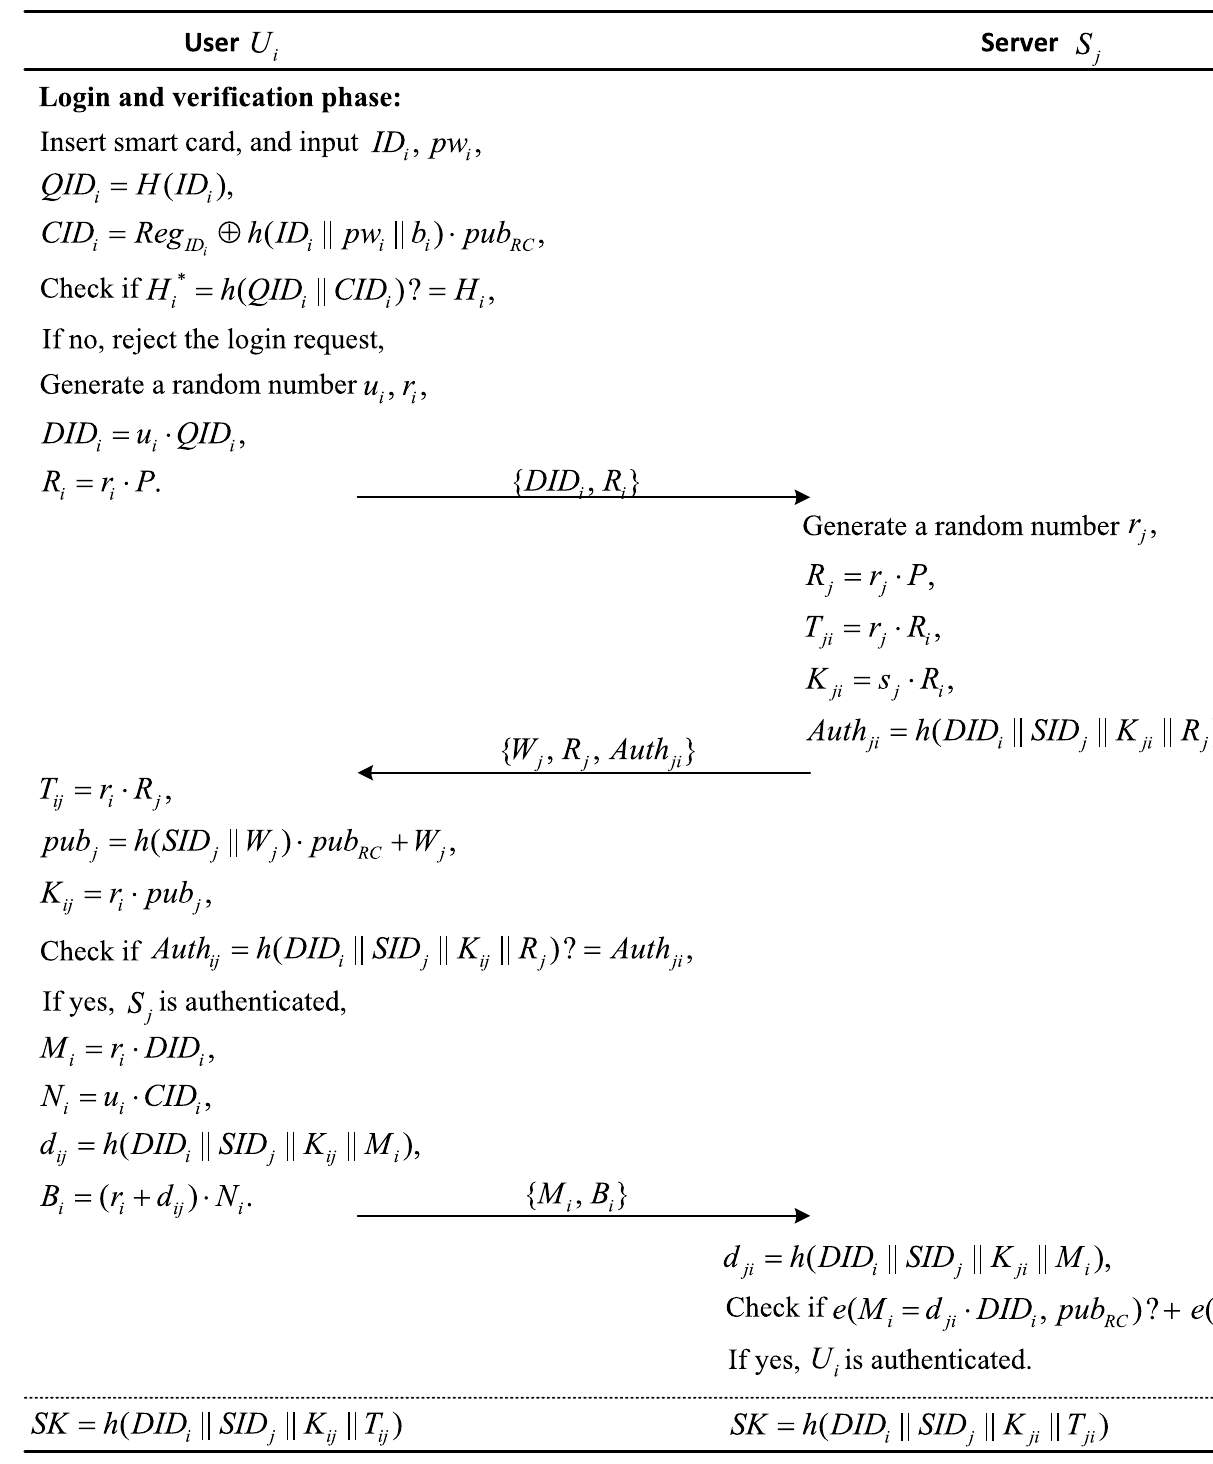
Fig 2. Login phase and authentication and session key agreement